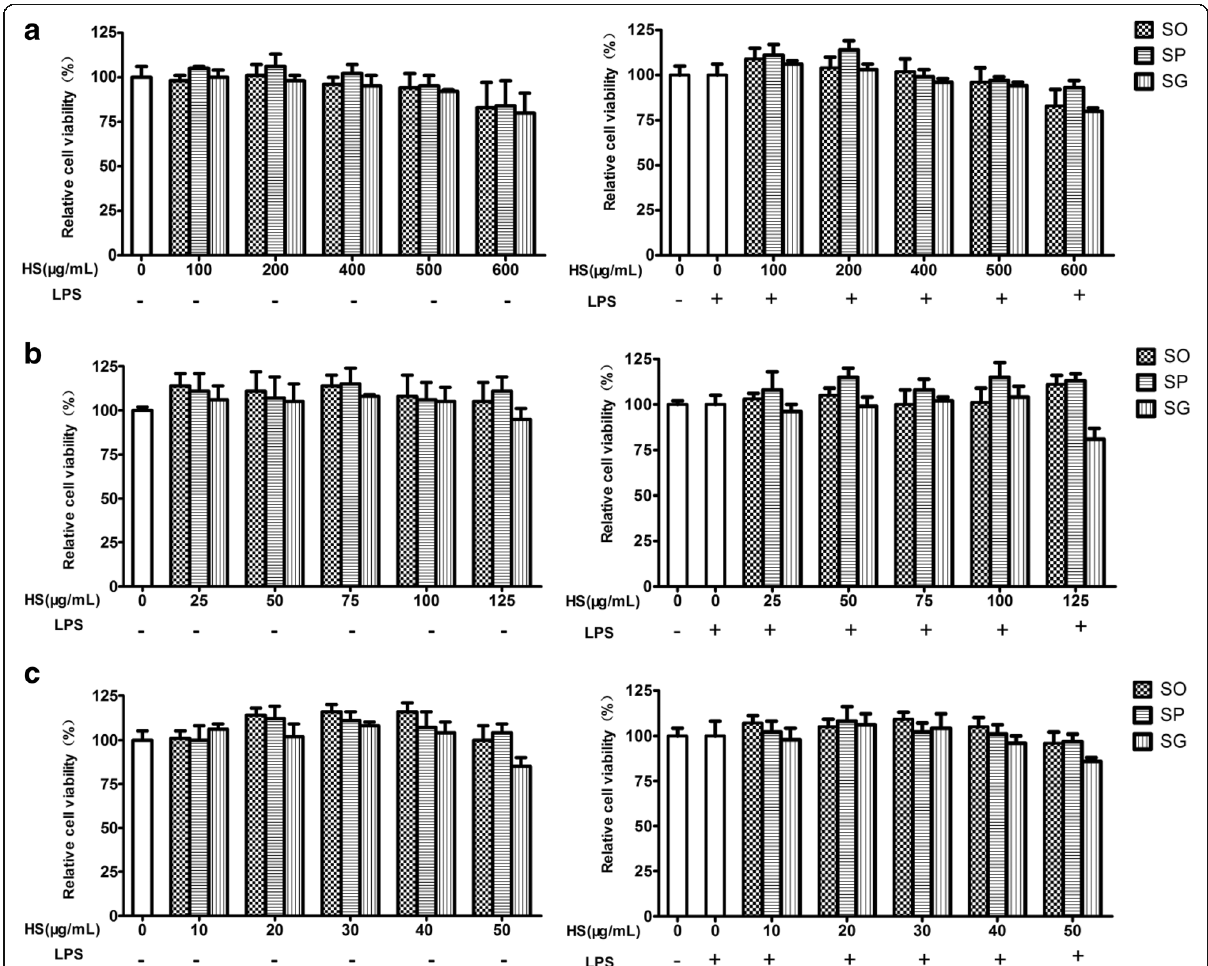
Fig. 3 Effects of HS extracts (SO, SP and SG) on the viability of RAW 264.7 macrophages. a Water extracts; b 50% ethanol extracts; c 95% ethanol extracts. The cells were incubated with the indicated concentrations of HS extracts for 24 h with (right panel) or without LPS (left panel). Cell viability was determined by the MTT assay. Results were expressed as the percentage against respective